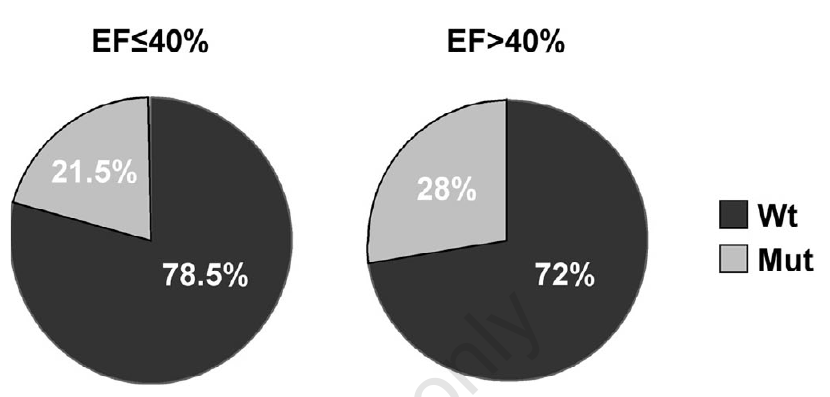
Figure 3. MMP9 polymorphism and LV remodeling after MI. Two groups of patients were selected from the population of MI patients depending on their EF: EF£40% (n=79) and EF>40% (n=389). Pie-charts represent the proportion of patients having (mut, mutated) or not (wt, wild-type) the polymorphism in each group. Differences were not statistically significant